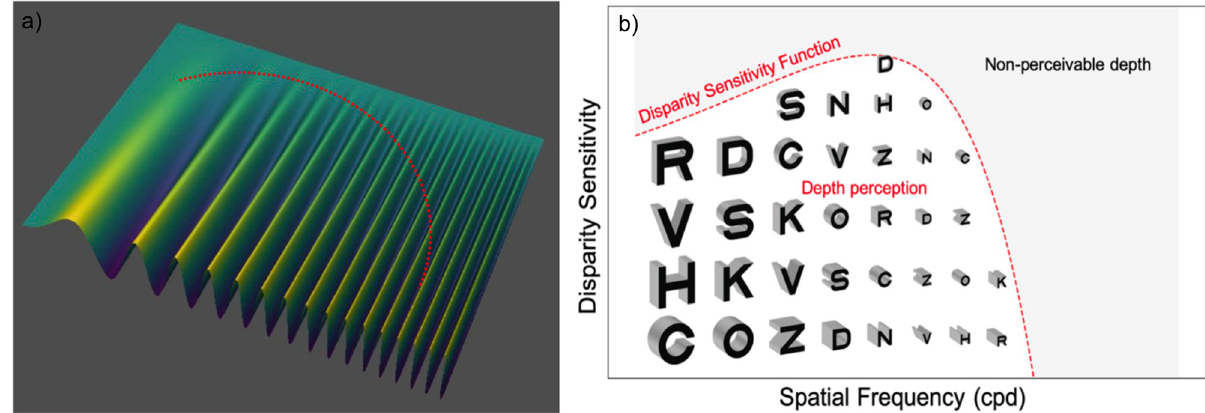
Fig 1. Depth corrugations as a function of spatial frequency. a) Illustration of a surface propagating in sinusoidal depth used in other studies. The dotted red curve depicts the disparity sensitivity function, DSF with peak sensitivity at middle spatial frequency. b) Illustration of letter optotypes in various depth and sizes used in our disparity defined letter test to assess DSF. The dotted red curve indicates the hypothetical stereo threshold at each spatial frequency (or letter size). The shaded region outside of the DSF is the non-perceivable depth region.